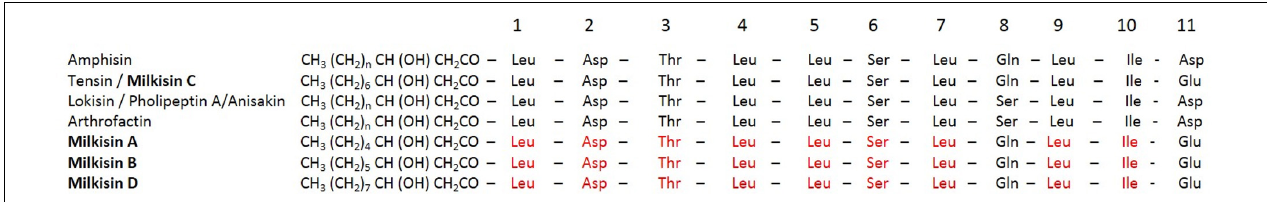
FIGURE 8 | Alignment of lipopeptide milkisin isoforms produced by Pseudomonas sp. UCMA 17988 with members of amphisin group.